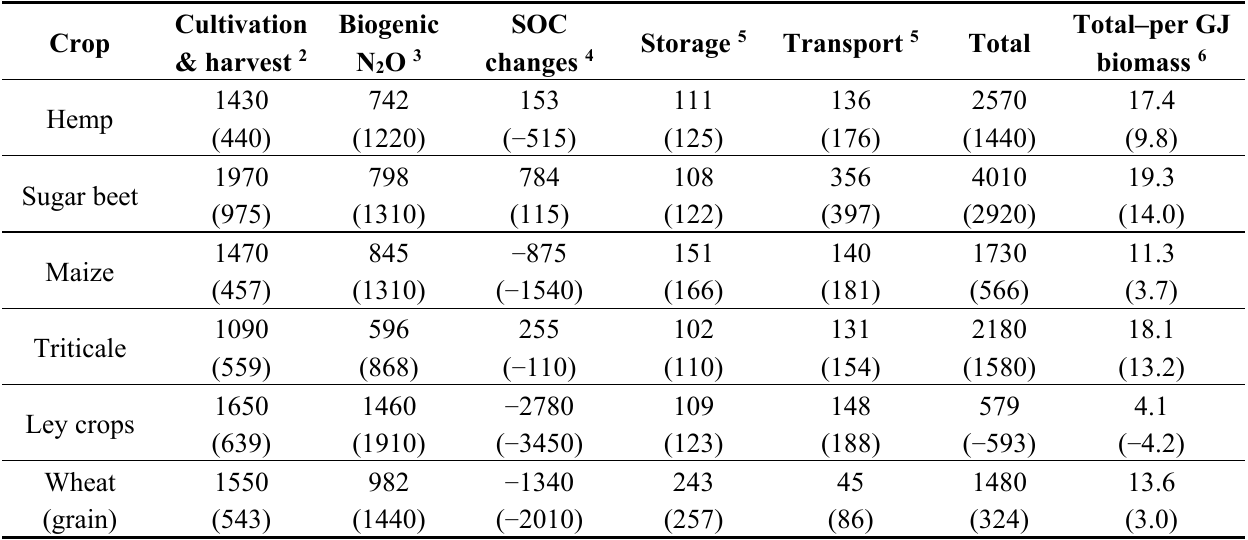
Table 2. Emissions of GHG’s from different biogas crop production systems, expressed as kg CO 2 -equivalents per hectare and year 1